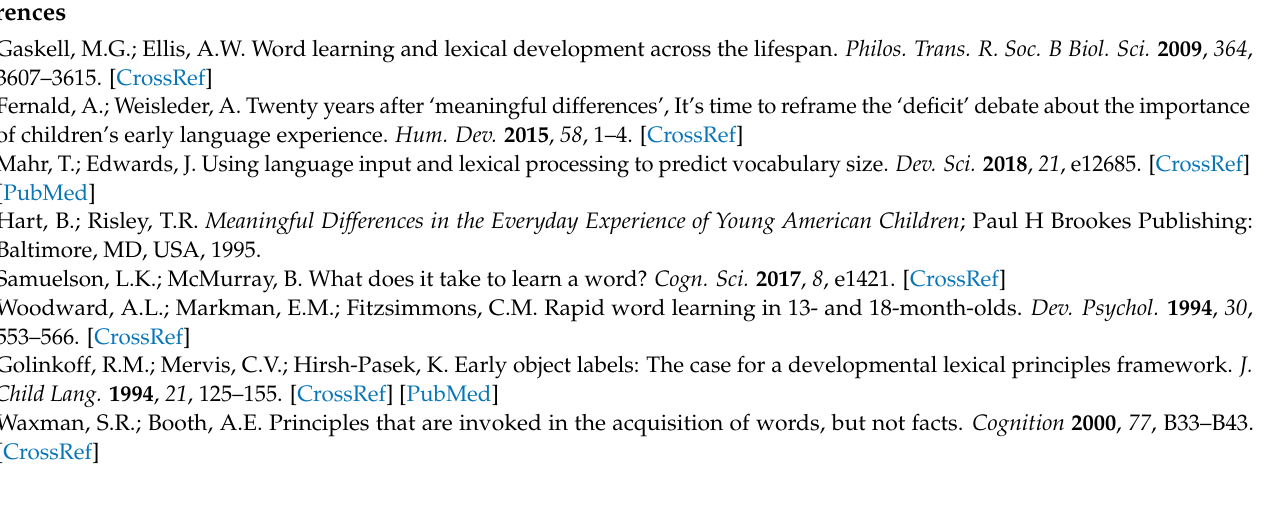
Table S1: Ostensive Naming Group’s One-sample t-tests Comparing Fast Mapping and Retention to Chance; Table S2: Ostensive Naming Group’s Retention Across Immediate, Afternoon, and Post-nocturnal Tests; Table S3: Ostensive Naming Group’s Condition by Testing Session Fixed Effects Parameter Estimates; Table S4: Comparison of Ostensive and Non-ostensive Naming Groups’ Retention Across Immediate, Afternoon, Post-nocturnal Tests; Table S5: Group by Condition by Test Session Fixed Effects Parameter Estimates; Table S6: Time Intervals from Fast Mapping to Sleep Onset and the Afternoon and Post-nocturnal